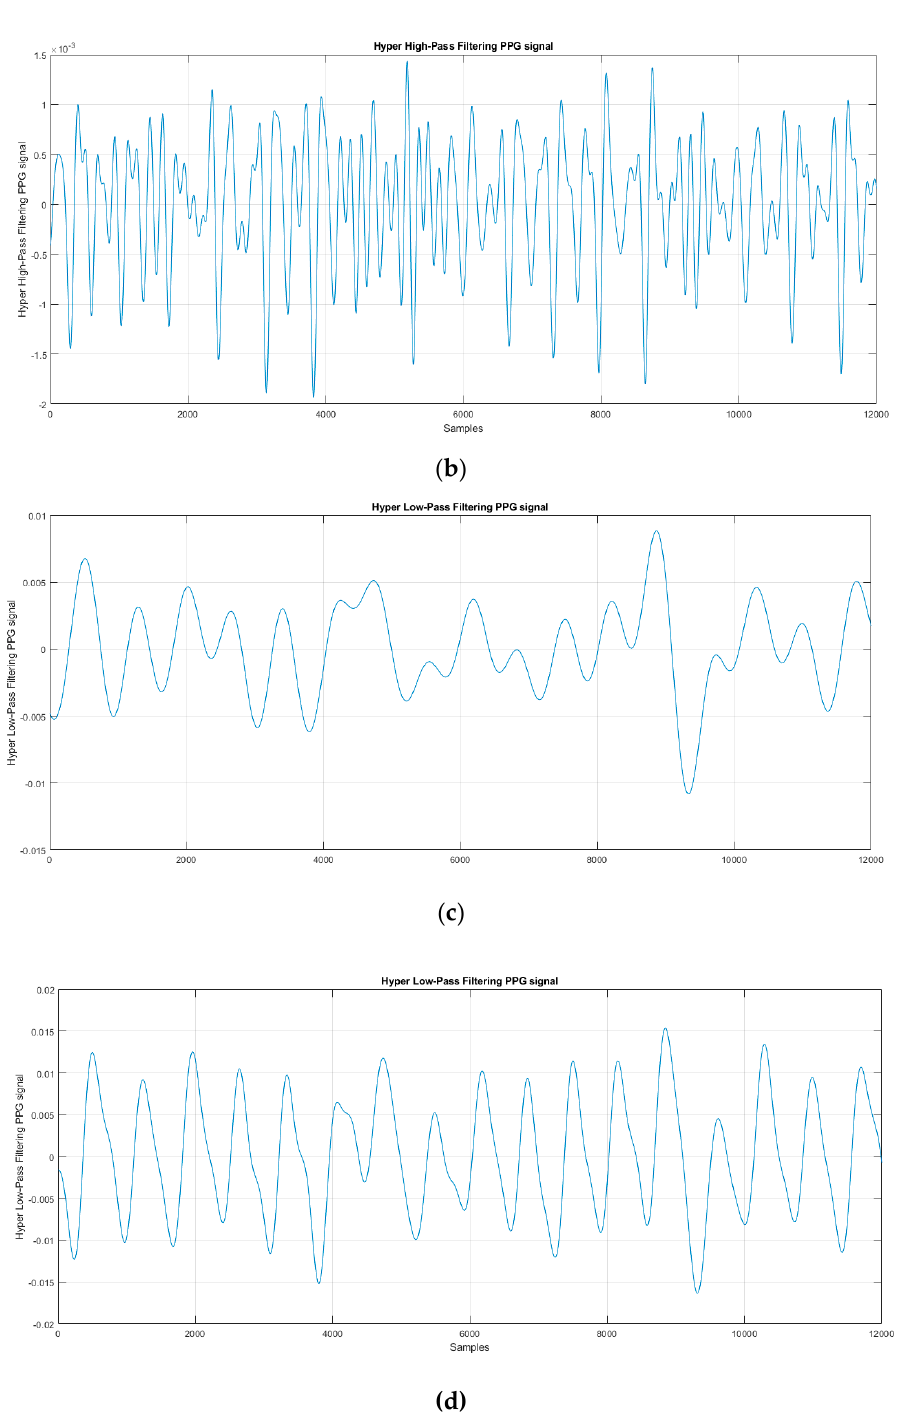
𝐢 (𝐤) ; ( c,d ) instances of ( k ) ; ( c,d ) instances of the H HP 𝐇𝐏 𝐢 (𝐤) . ( k ) H LP 𝐋𝐏